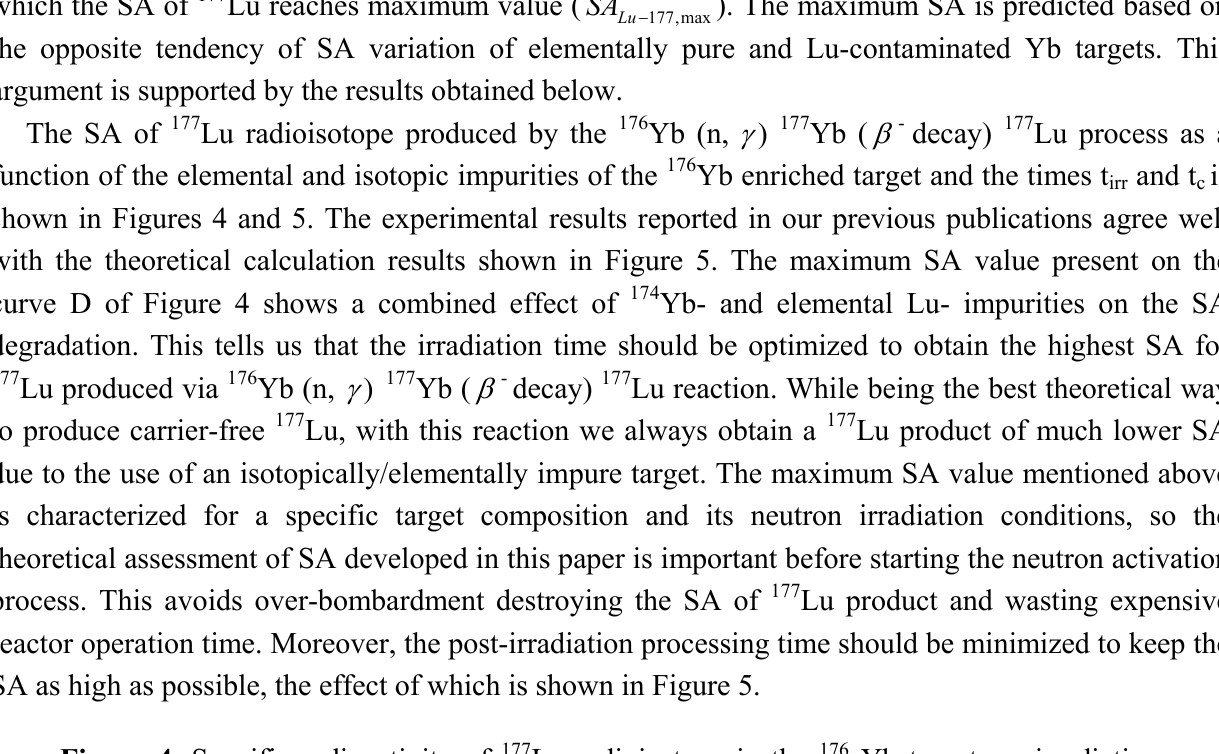
Figure 4. Specific radioactivity of 177 Lu radioisotope in the 176 Yb target vs. irradiation time and content of 174 Yb- and elemental Lu- impurities.(Thermal neutron